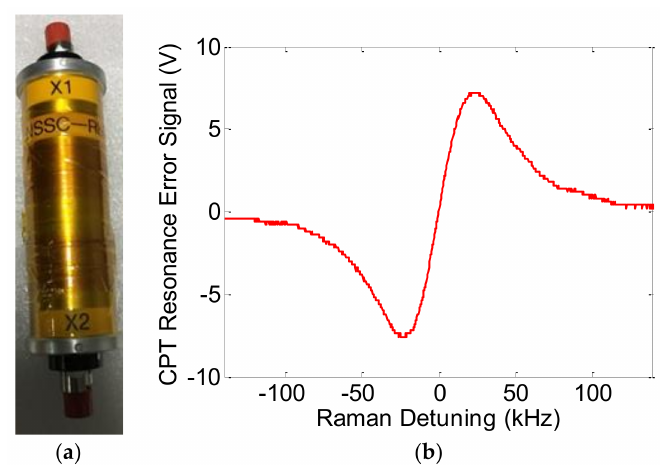
Figure 12. ( a ) Photo of the integrated physics package with polarization optics and the vapor cell; ( b ) Typical CPT 0-0 resonance error signal.